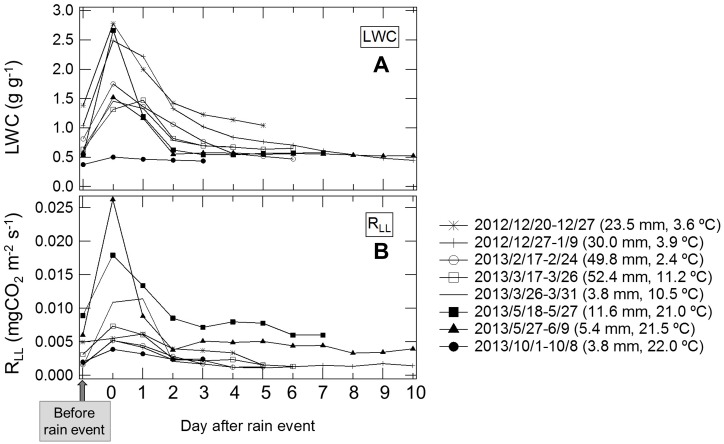
Temporal variation in water content of the leaf litter layer (LWC) and CO2 efflux from the leaf litter layer (R
LL) after rainfall events.LWC (A) and R
LL (B) show the daily mean values. The rainfall intensity of each precipitation event was 23.5 mm in 2 days (2012/12/20–12/27, mean air temperature; 3.6°C); 30.0 mm in 3 days (2012/12/27–1/9, 3.9°C); 49.8 mm in 2 days (2013/2/17–2/24, 2.4°C); 52.4 mm in 3 days (2013/3/17–3/26, 11.2°C); 3.8 mm in 2 days (2013/3/26–3/31, 10.5°C); 11.6 mm in 2 days (2013/5/18–5/27, 21.0°C); 5.4 mm in 3 days (2013/5/27–6/9, 21.5°C); and 3.8 mm in 4 days (2013/10/1–10/8, 22.0°C).